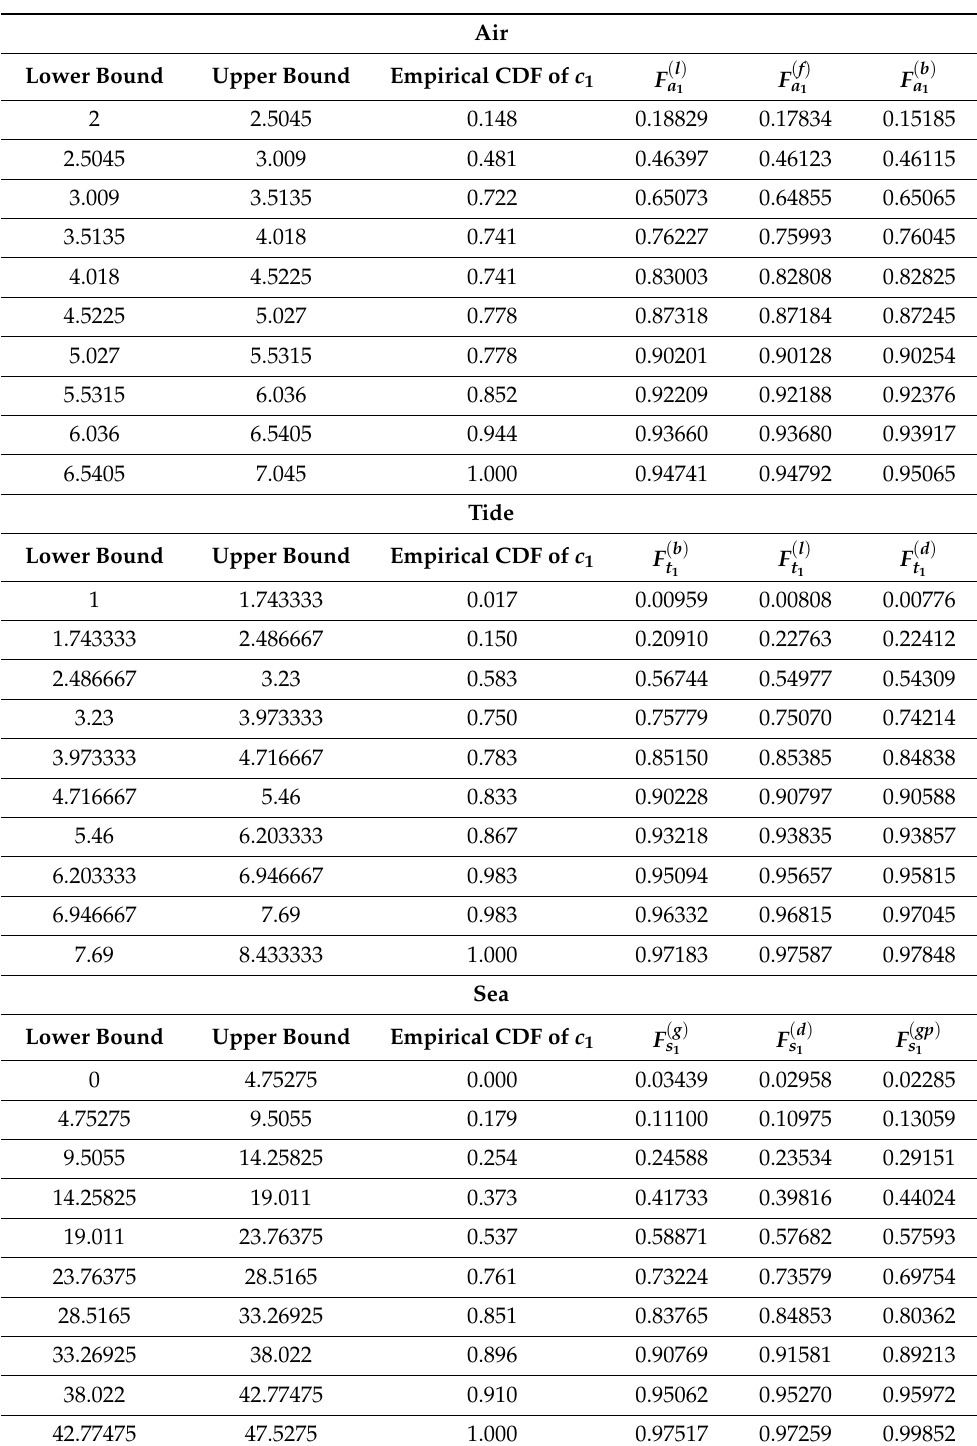
Table 10. The empirical values and the values of CDF for the three best-fitted distributions for c 1 concerning